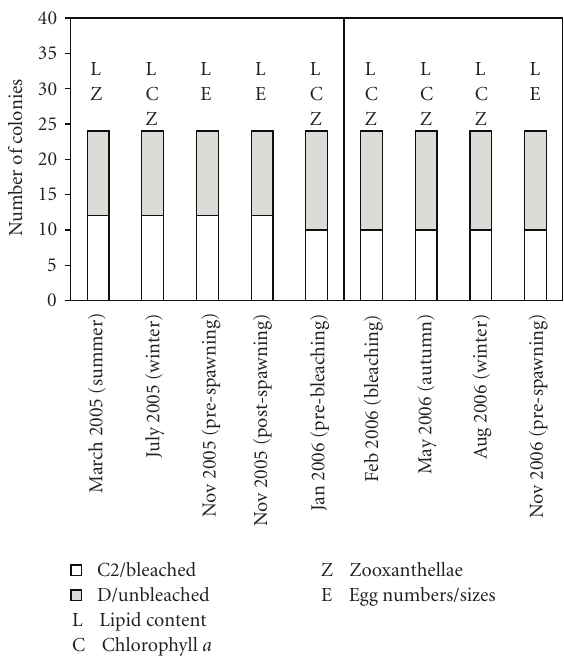
Figure 1: Sampling design for the study of storage lipids (L), algal chlorophyll a content (C), symbiont densities (Z), and egg sizes and numbers (E) in colonies of Acropora millepora sampled before (grey bars = D, white bars = C2) and after (grey bars = unbleached, white bars = bleached) a bleaching event in February 2006 (shown as a thick line between January and February